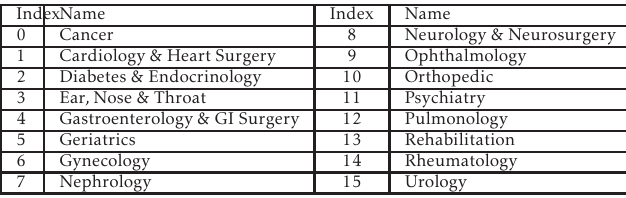
Table 7. Experiment platform